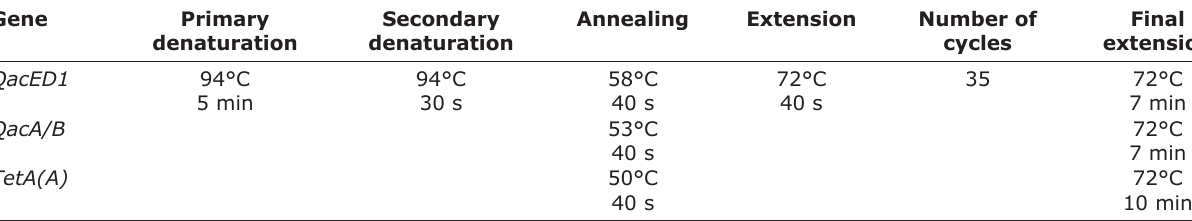
Table-2: Cycling conditions of the different primers. Gene